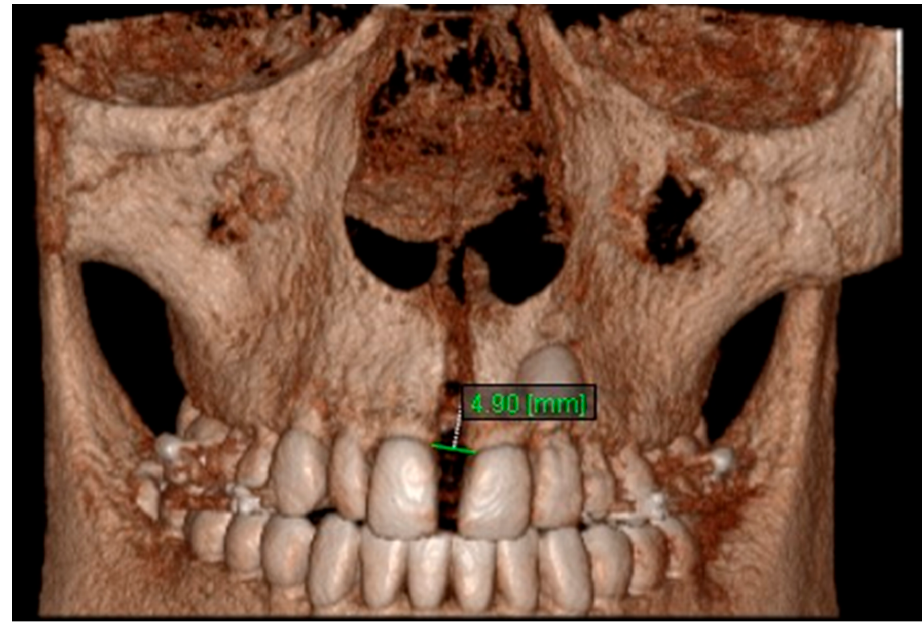
Figure 13. Aperture of Midpalatal Suture 11.